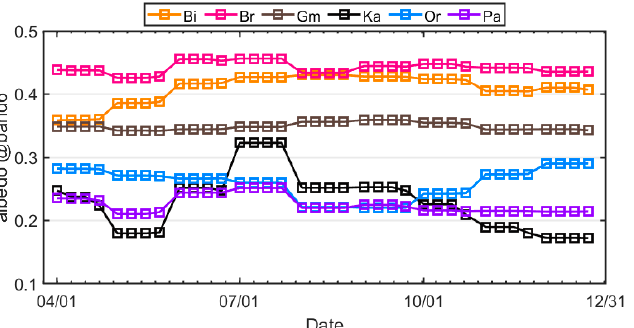
Figure A1. Weekly averaged surface albedo at the six TCCON sites based on the MODIS MCD43C3 products at band 6 (1.628–1.652 µ m).